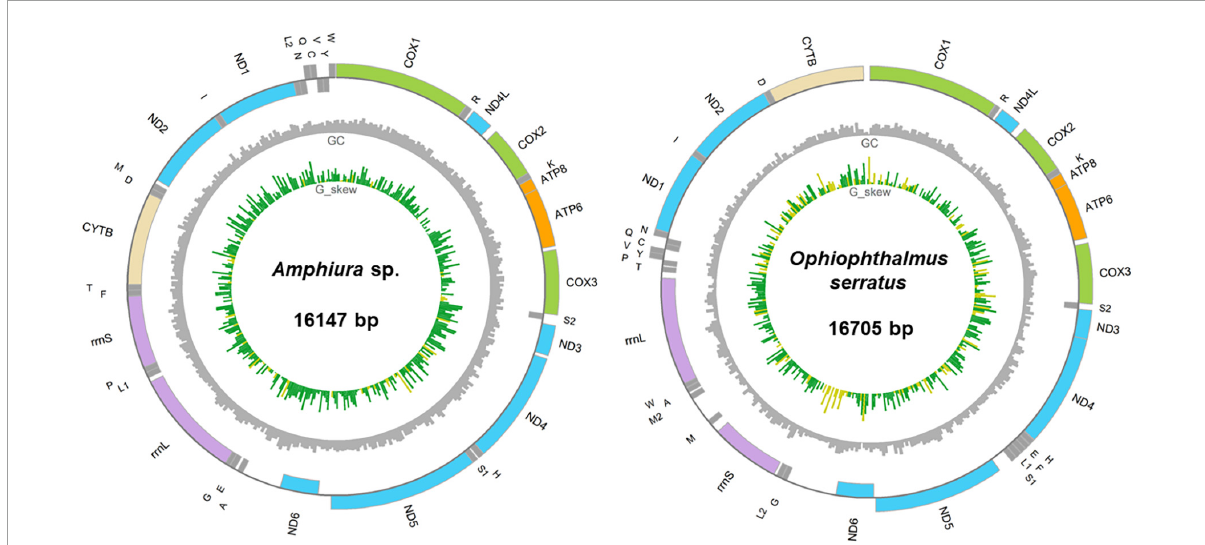
FIGURE2 Circular map of two sequenced cold-seep ophiuroids, Amphiura sp. and Ophiophthalmus serratus . Circular tracks from inside to outside is GC skew, GC percentage with window size 40 bp and genes. Yellow bars in the GC skew track indicated positive value and green ones were negative value. Outward (inward) genes are on the heavy (light) strand.